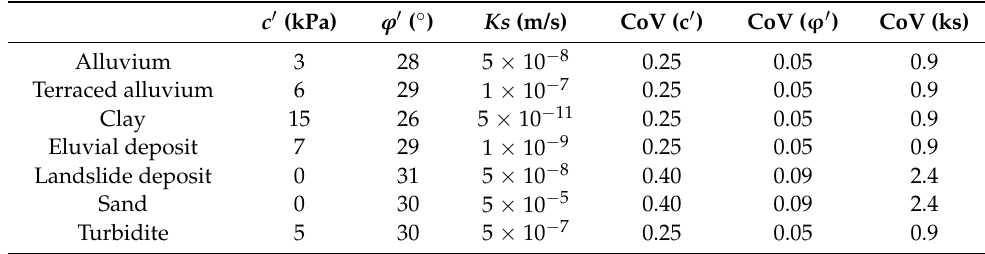
Table 1. The table summarizes the stochastic parameters (mean value and coefficient of variation, CoV) used to characterize the soils in the study area (according to Fanelli et al., 2016 [55]). In the reliability analyses, rocks such as limestone, marl limestone, conglomerate, marl and travertine are not considered.